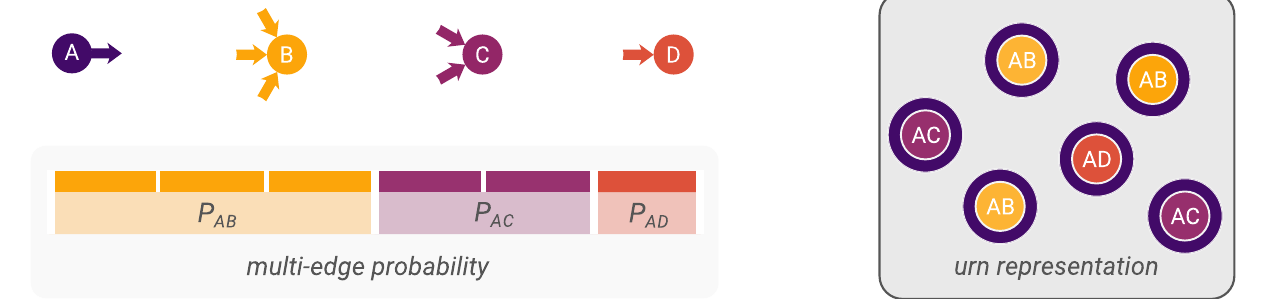
Figure 1. The configuration model represented (upper left) as a conventional edge rewiring process and (right) as an urn problem. In the former case, once the out-stub ( A , · ) has been sampled for rewiring, then one in-stub is sampled uniformly at random from those available, to draw a new multi-edge. If we represent each possible combination of an out-stub and an in-stub as a ball, we arrive at the urn problem without replacement. For the shown vertices, the odds of observing a multi-edge ( A , B ) are three times higher than of observing a multi-edge between ( A , D ) and 1.5 times higher than of observing a multi-edge between ( A , C ) in both model